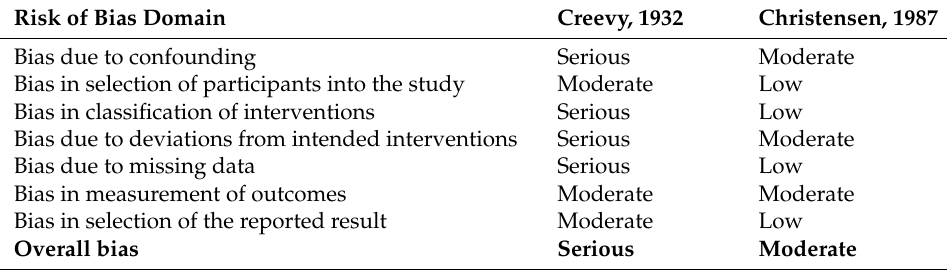
Table 4. Risk of bias in non-randomized studies